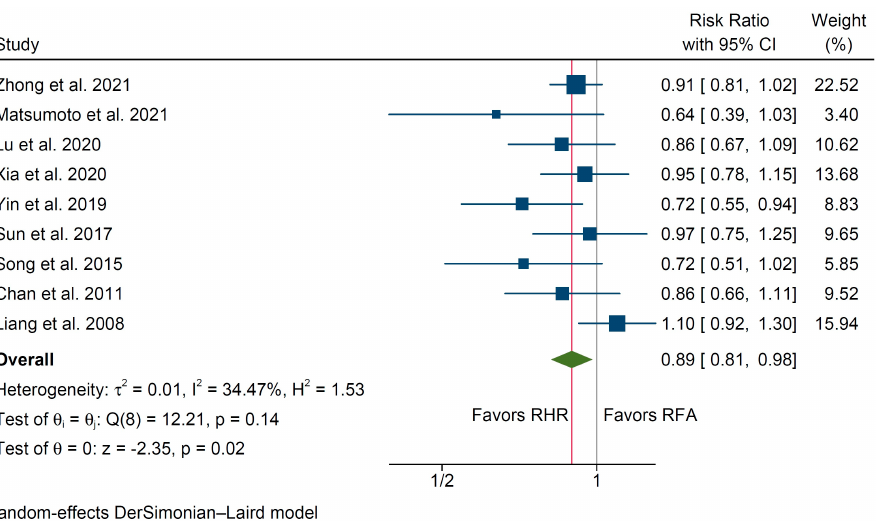
Figure 3. Forest plot for Disease-Free Survival of patients undergoing repeat hepatic resection (RHR) versus radiofrequency ablation (RFA) of recurrent hepatocellular carcinoma [22 – 28,30 – 32,34,36].